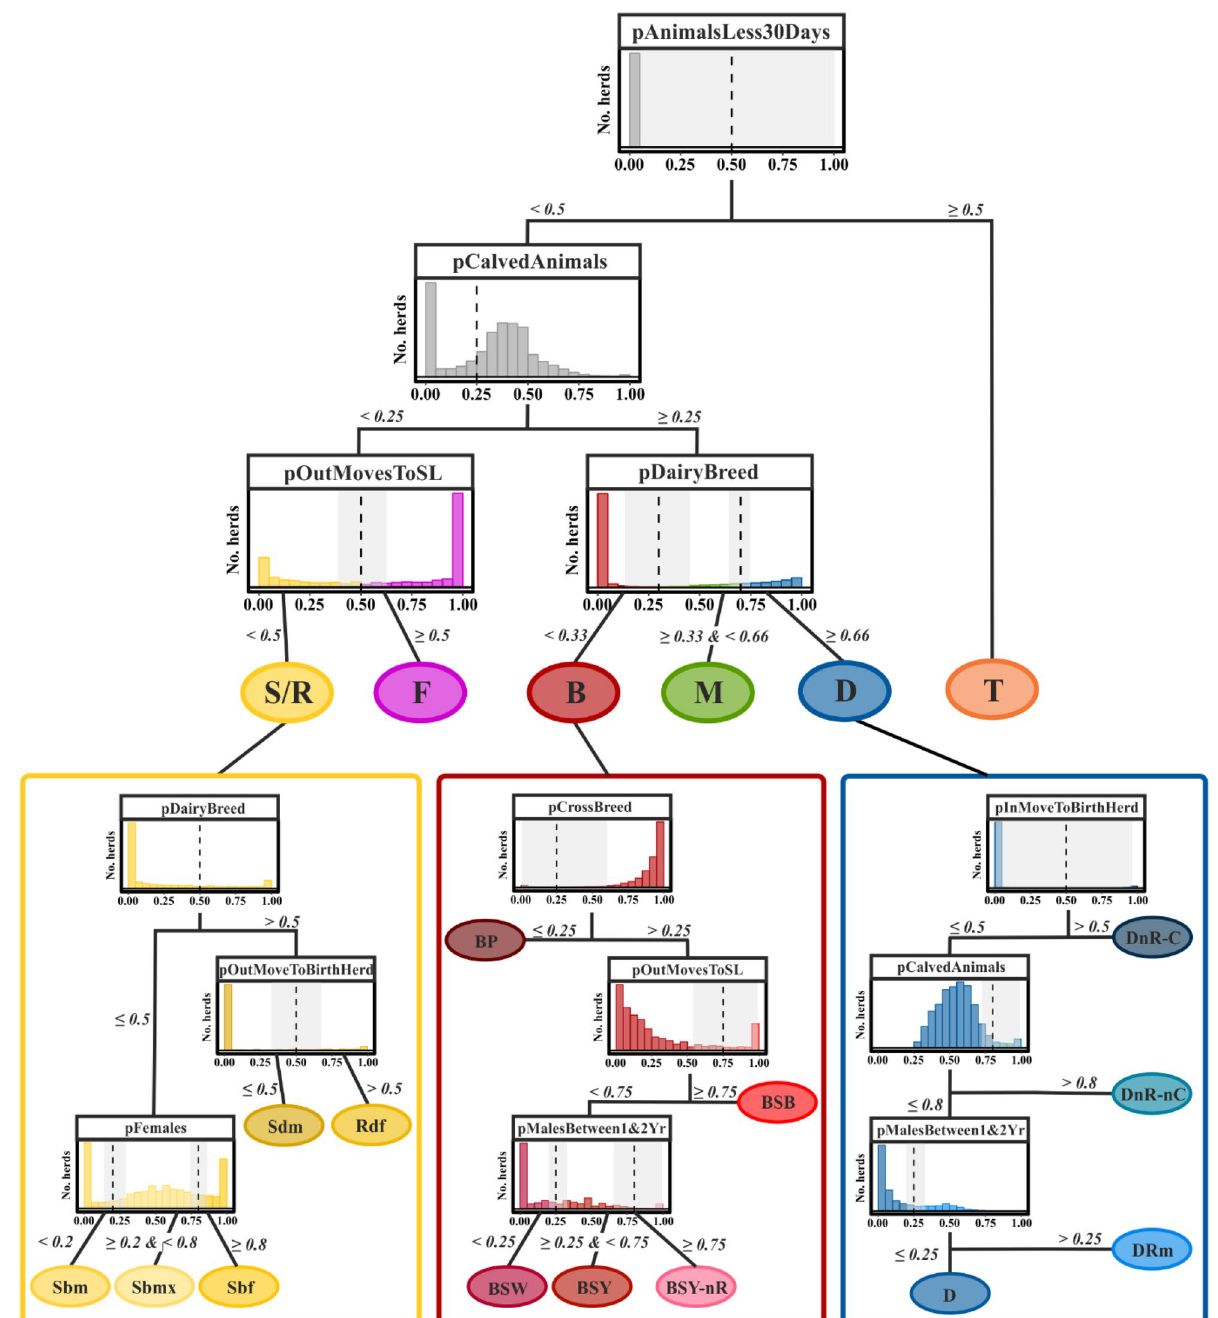
Figure 5. A decision tree for the classification of the Irish cattle sector. Histograms represent herds remaining at the respective node. Numbers and dashed line demarcate thresholds for class assignment. Main herd types: dairy (D), beef (B), mixed (M), store/rearing (S/R), fattening (F), and trading (T) herds. Dairy sub-types: dairy (D), dairy no rearing—contract (DnR-C), dairy no rearing—no contract (DnR-nC), dairy rearing male calves (DRm). Beef sub-types: beef pedigree (BP), beef suckling to weanlings (BSW), beef suckling to youngstock (BSY), beef suckling to youngstock—no rearing (BSY-nR), beef suckling to beef (BSB). Store/rearing sub-types: store dairy males (Sdm), store beef males (Sbm), Store beef females (Sbf), store beef mixed (Sbmx), rearing dairy females (Rdf). The grey rectangles among the thresholds indicate the range in which the classification threshold would have to be moved in order to assign 10% of the herds classified in the respective step to the other